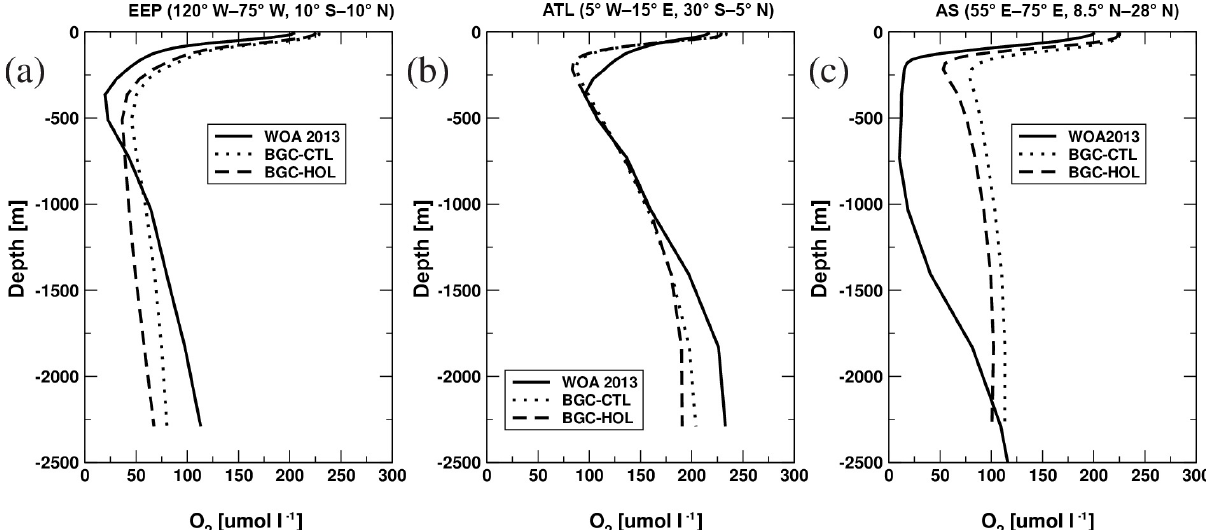
Figure A1. Simulated and observation-based profiles of average O 2 concentration in µmolL − 1 in the three major oxygen minimum zones in the world ocean for (a) the EEP, (b) the tropical South Atlantic, and (c) the Arabian Sea. Based on observations (WOA2013, Garcia et al., 2013, solid), and from experiments BGC-CTL (dotted) and BGC-HOL (dashed) averaged over the last 200